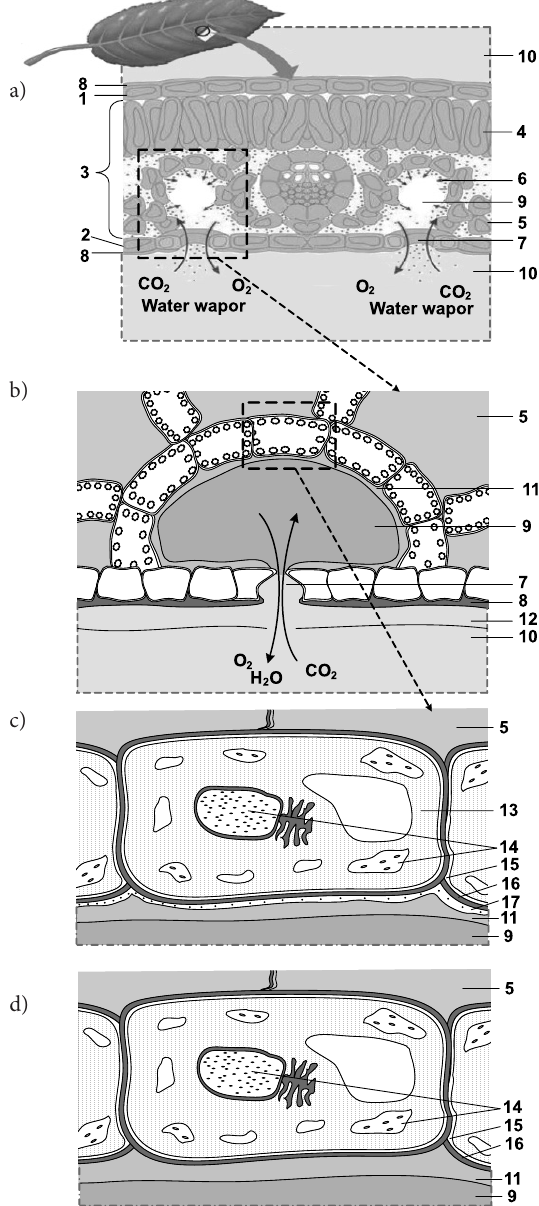
Figure 1. a – Chart of the plant leaf anatomical structure and gas exchange with the environment; b – Model of the internal boundary layer of the internal and external surfaces of a leaf (CO 2 , O 2 , H 2 O vapour); c – Model of the internal boundary layer of the internal surface of a leaf when water condensate forms on a cell surface in the period of temperature drop; d – Model of the internal boundary layer of the internal surface of a leaf when water condensate evaporates from a cell surface in the period of temperature rise (Sage & Monson, 1999; Pirasteh‐ Anosheh et